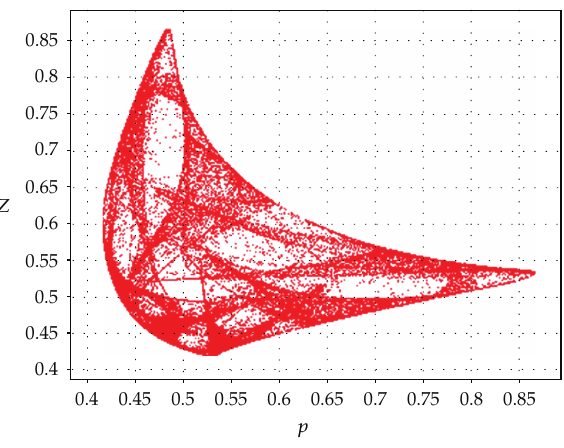
Figure 10: Grab the dollar game—strange attractor (cid:3) x (cid:7) 0 . 2 (cid:4)